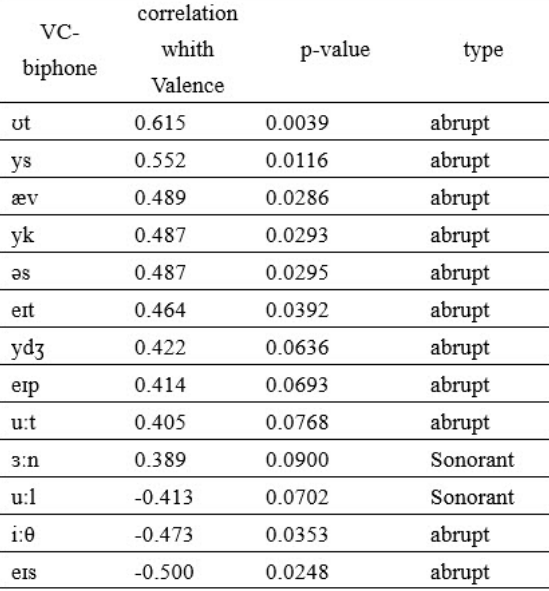
Table 2. Pronounced Correlation of sep- arate VC-biphones with the Valence score